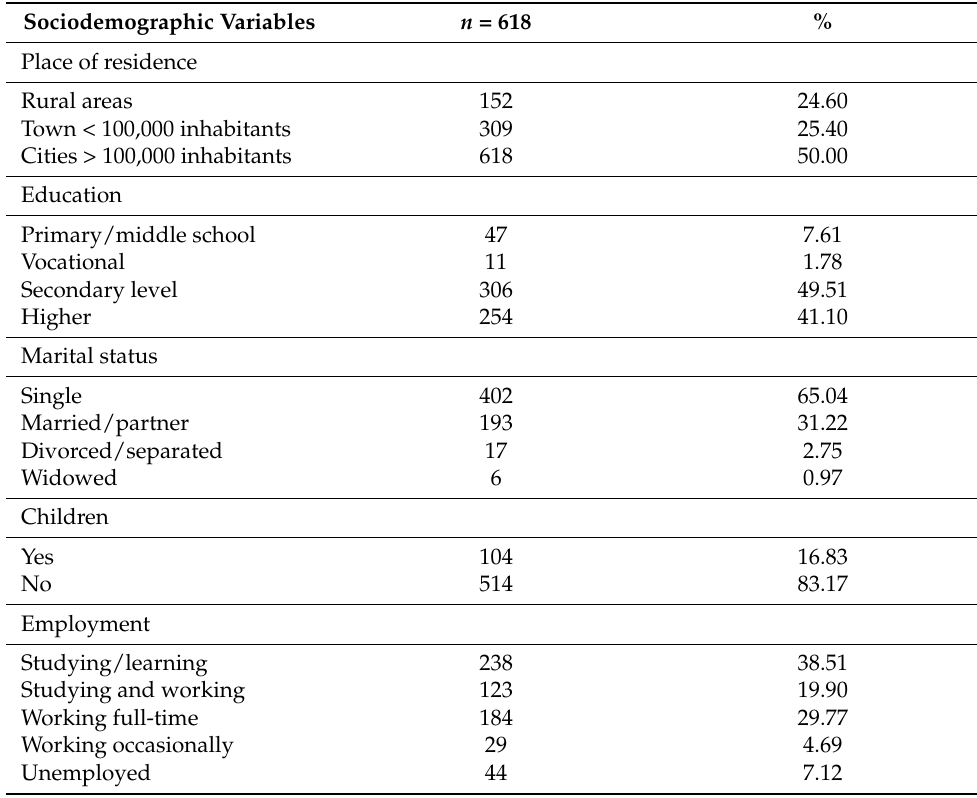
Table 1. Characteristics of the sample: sociodemographic variables.